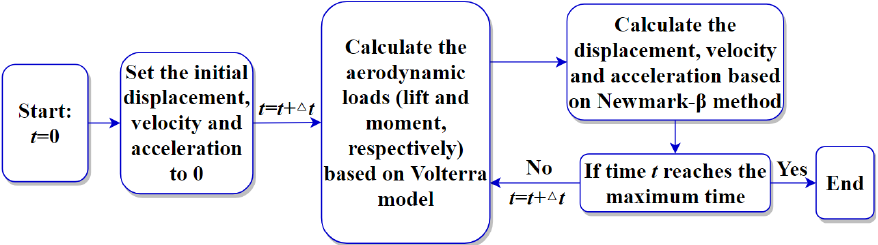
Figure 6. Schematic representation of the numerical simulation based on the Volterra model.